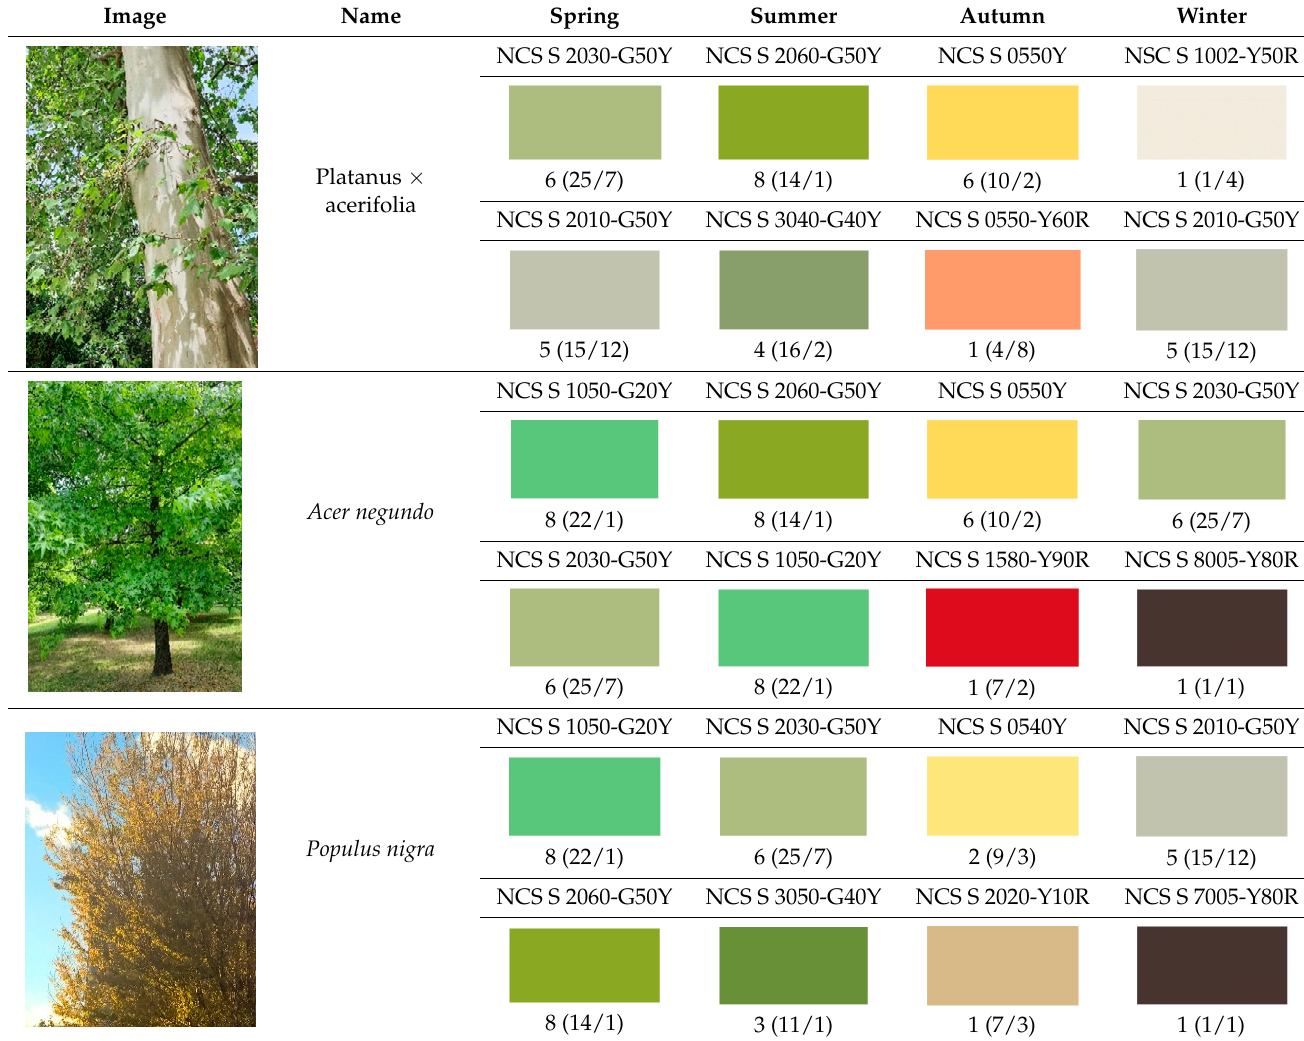
Table A1. Eighty-eight color samples taken from trees identified in the research area. The numbers below the color sample provide the information how many times a given color appears in the table (how many times it appears in all natural samples/how many times it appears in the analyzed architectural objects). Image.